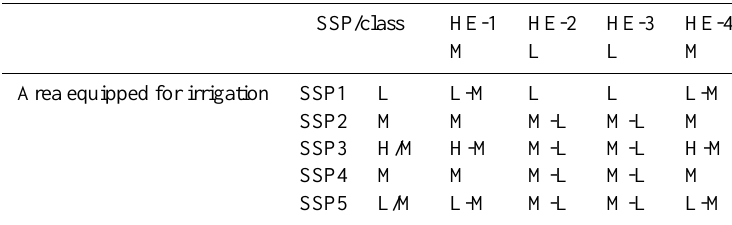
Table A19. Water dimension – assumptions regarding expansion of area equipped for irrigation.